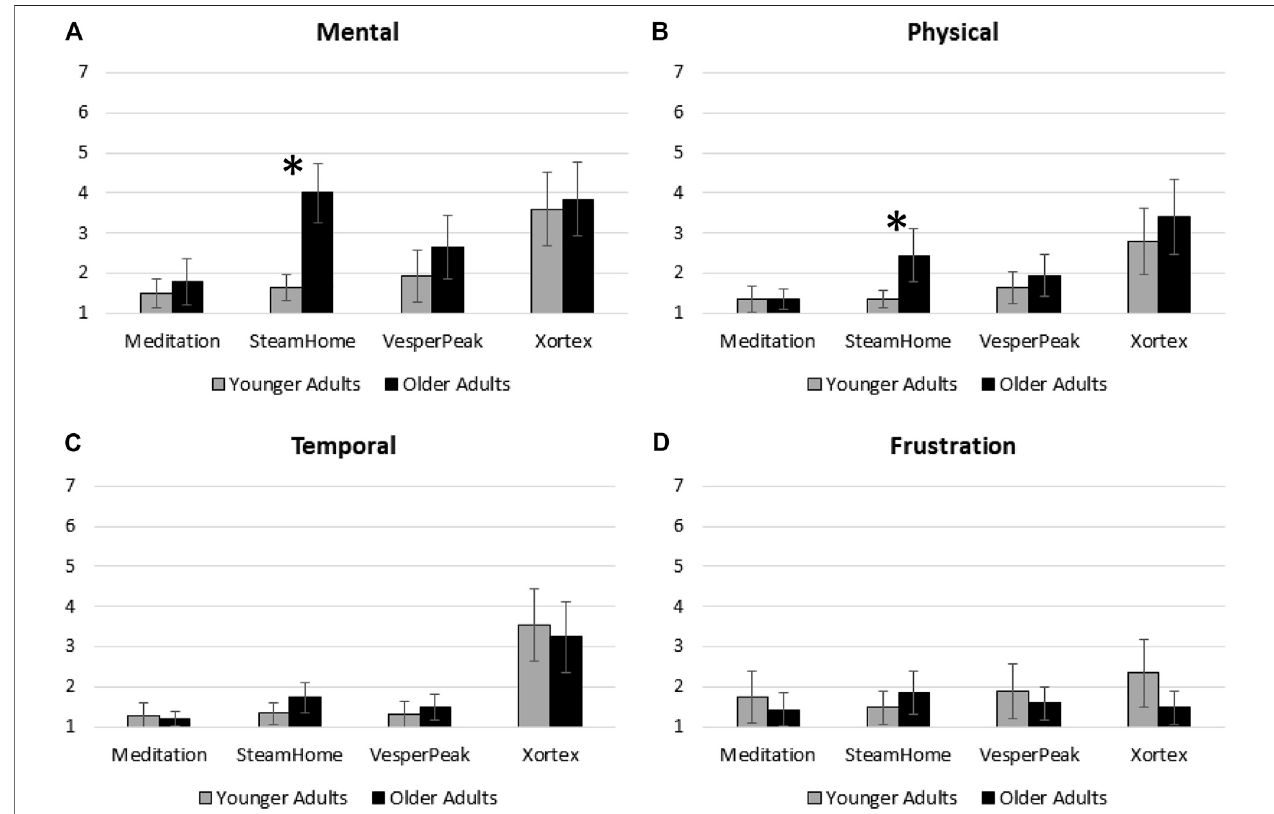
FIGURE 3 | Workload measures as a function of age and VR Experience for measures of mental, physical, and temporal demand, as well as frustration. Error bars represent 95% Con fi dence Intervals. * (cid:1) signi fi cant age contrasts, p < .05. N (cid:1) 20 younger adults, 20 older adults.